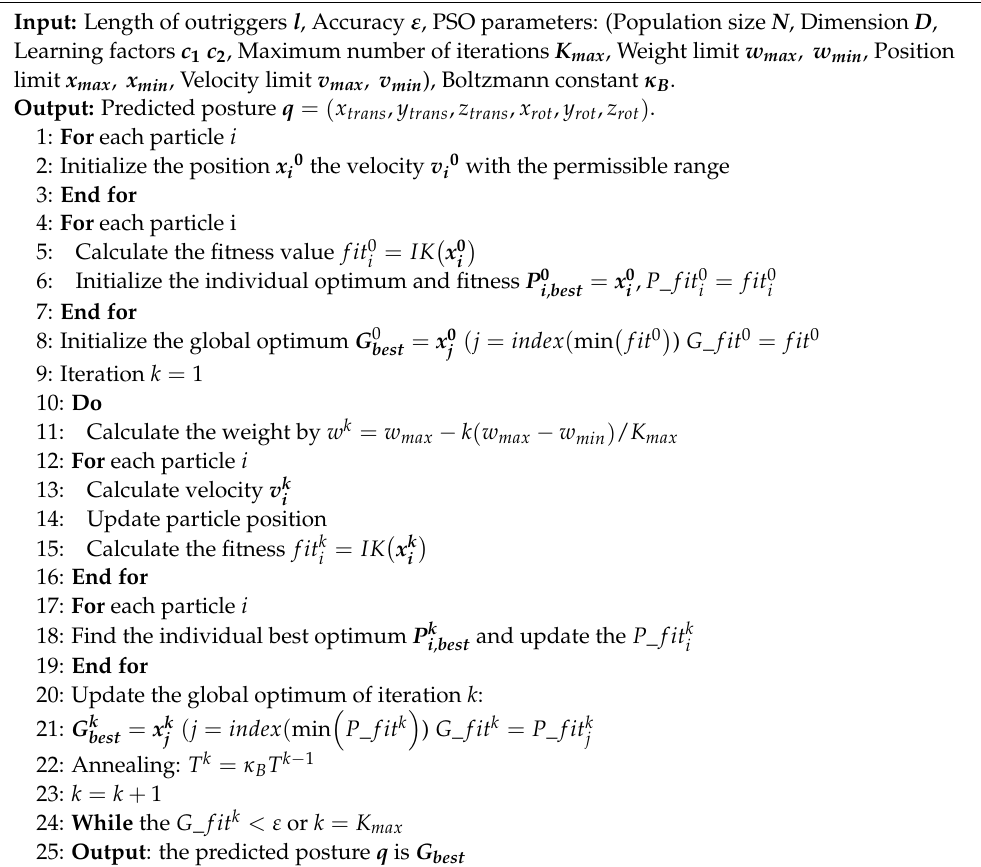
Algorithm 1: Simulated Annealing Particle Swarm Optimization (SA–PSO) for